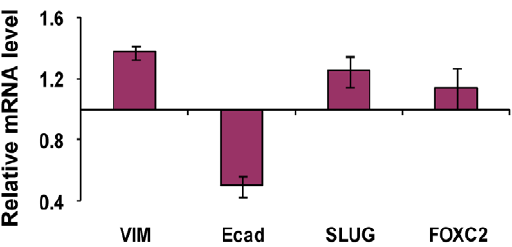
Figure 4. PROCR + /ESA + cells express markers associated with epithelial-mesenchymal transition (EMT). Gene expression levels of vimentin, E-cadherin, Slug and FOXC2 in PROCR + /ESA + relative to PROCR 2 /ESA 2 cells were assayed using real-time PCR. GAPDH mRNA was used as an internal control. Results are means 6 SD of triplicate experiments.